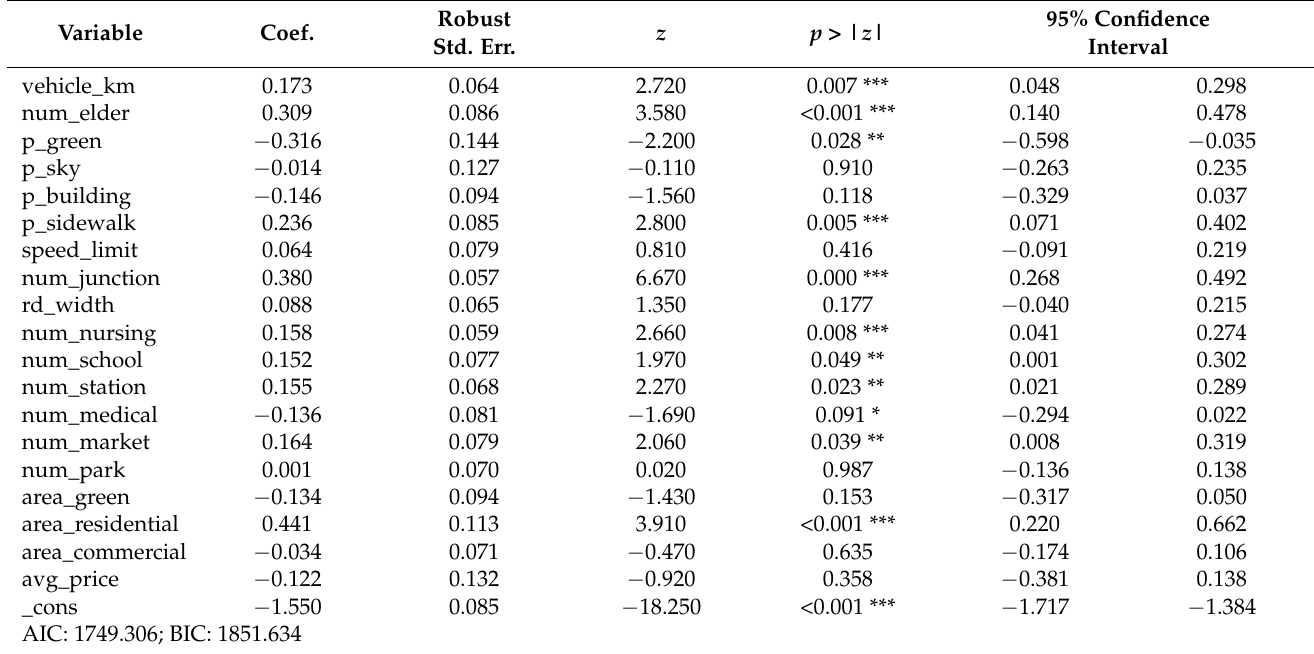
Table 2. The estimation results of the global Poisson model for independent